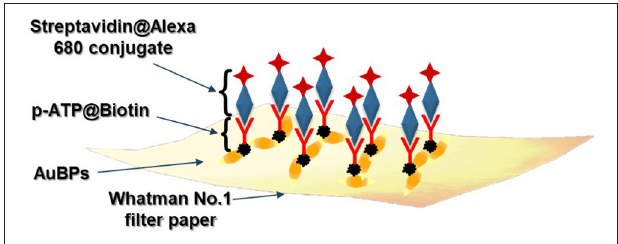
SCHEME 1 | Schematic illustration of the proposed biosensing